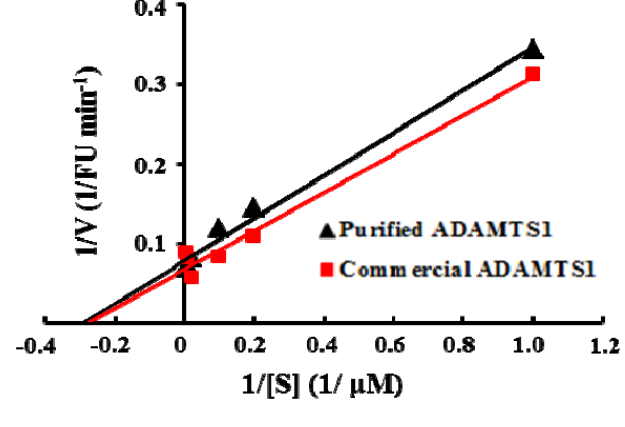
Figure 3. Lineweaver-Burk plots for purified E. coli and mammalian cell expressed ADAMTS1 at 0, 10, 25, 50, 100 and 150 µM concentrations of the substrate peptide.